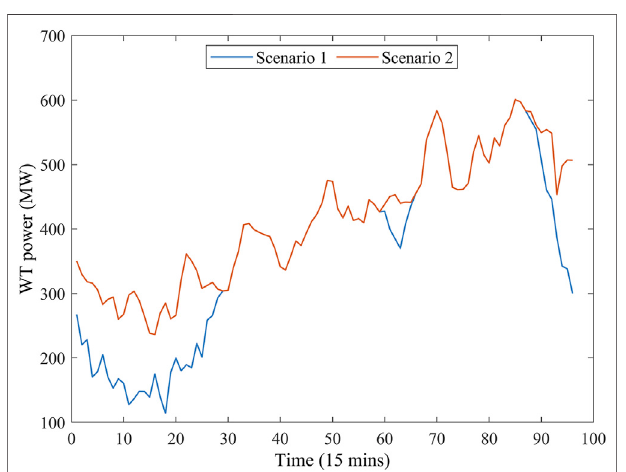
FIGURE 9 | Wind power generations in Scenarios 1 and 2.